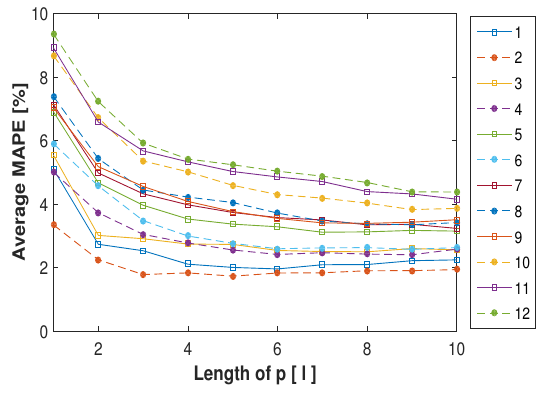
Figure 13. Average MAPE according to p .